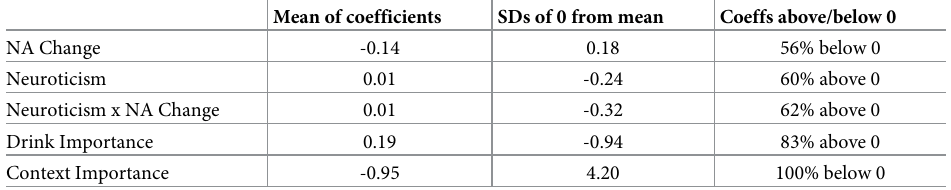
Table 8. Bootstrapped means of coefficients, z-scores of 0 from the means and the percentage of bootstrapped coefficients out the 5000 coefficients that are above or below zero.